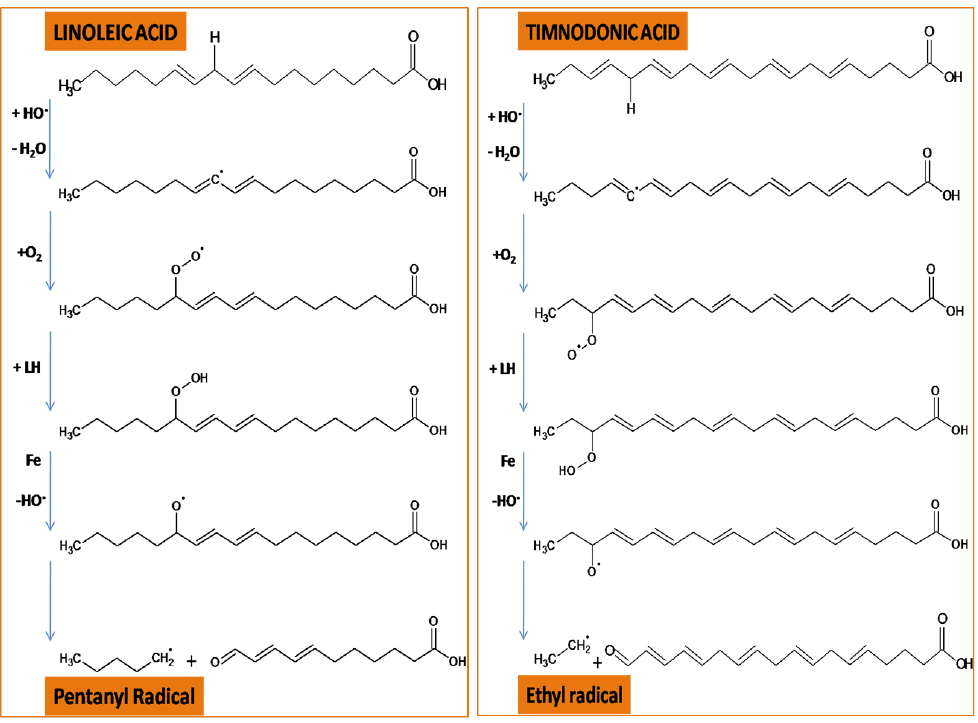
Figure 2: Lipid peroxidation triggered by reactive oxygen species. Production of pentane and ethane from polyunsaturated fatty acids − linoleic acid and timonodonic acid